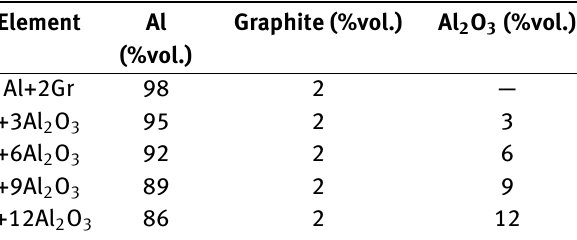
Table 1: Chemical compositions of produced AMC